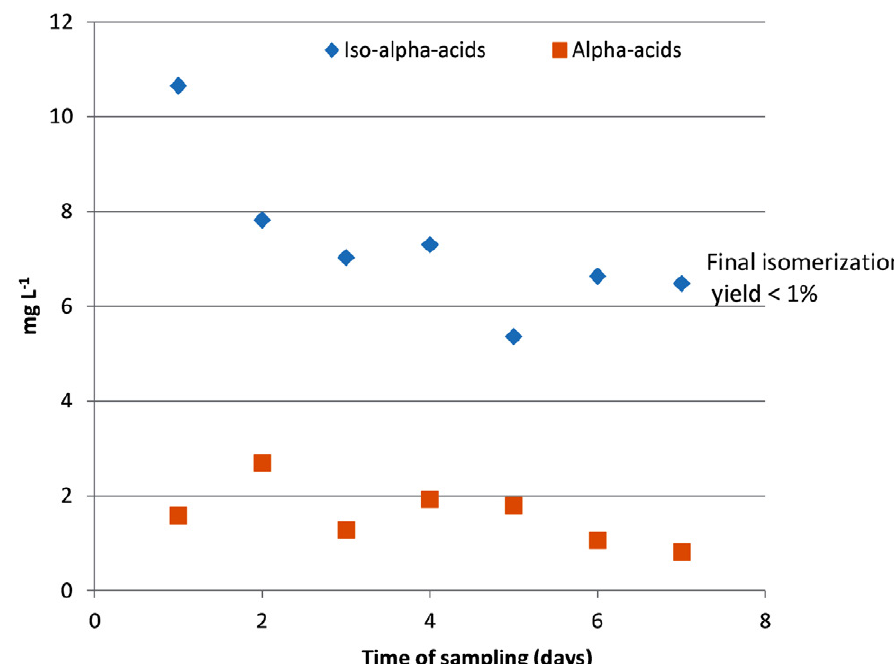
Figure 2. Dynamic of isomerization of alpha-acids in beer